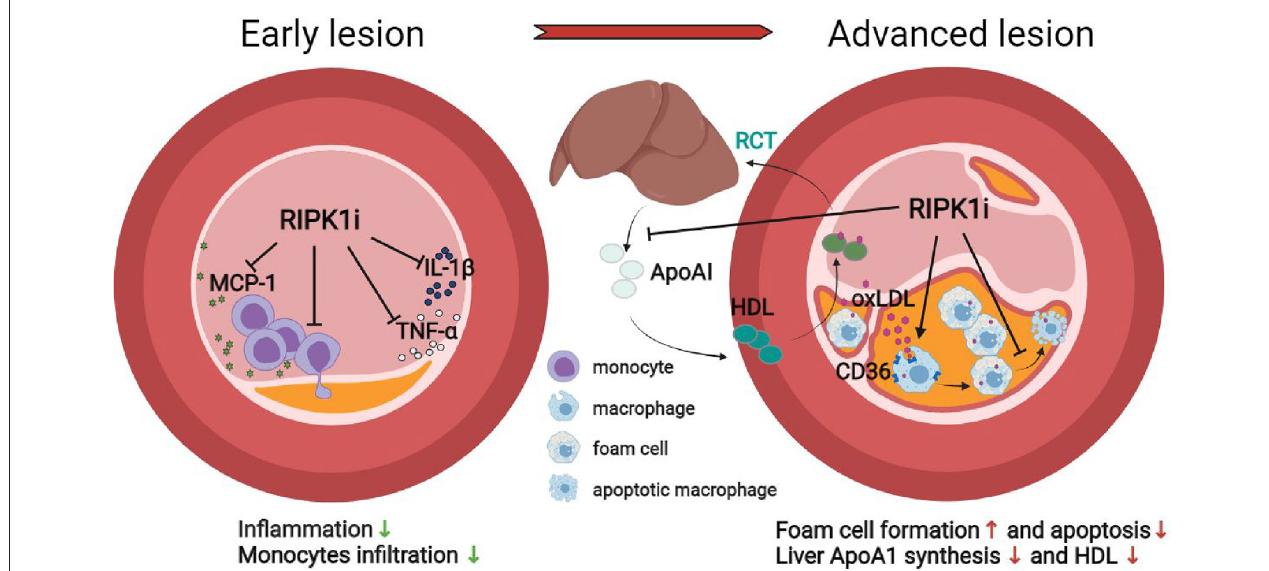
FIGURE 7 | Schematic illustration of the stage-dependent impact of RIPK1i in atherosclerosis.